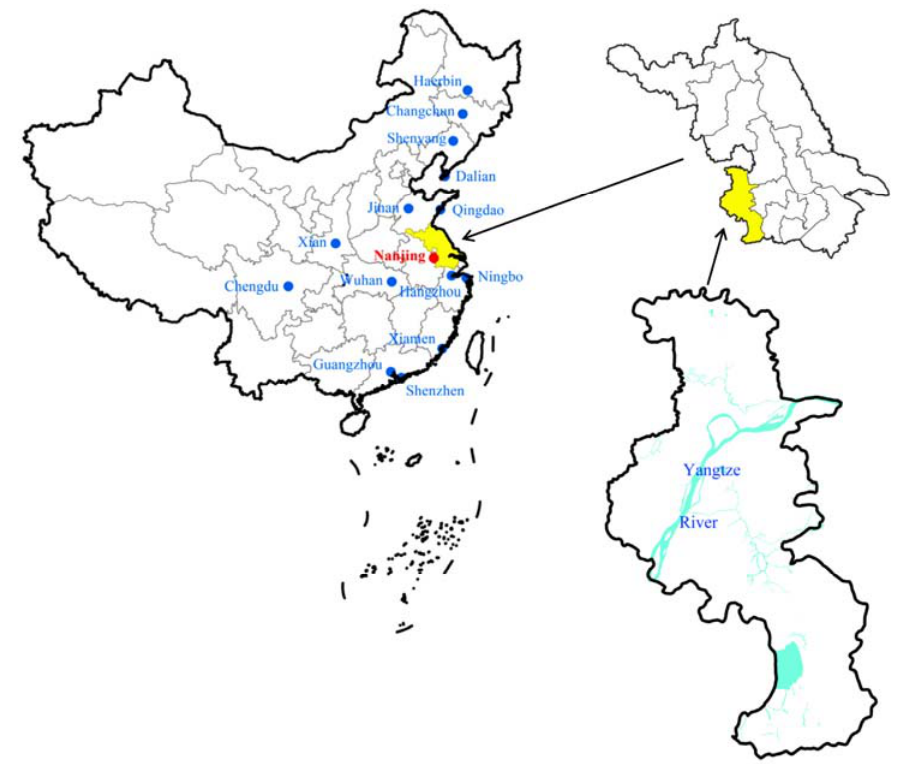
Figure 1. Location of Nanjing city in Jiangsu province, China.